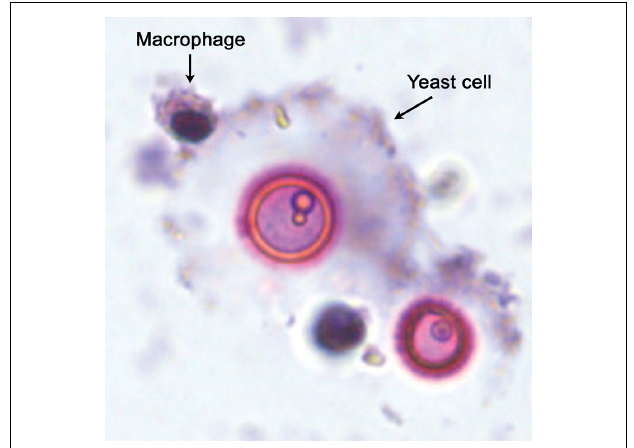
FIGURE 2 | Interaction between macrophages and cryptococcal giant/titan cells. Fungal giant/titan cells obtained from infected mice were co-incubated in vitro with RAW264.7 macrophage-like cells. As shown in the figure, the macrophages can recognize and bind to the fungal giant/titan cells, but they cannot internalize the fungal cells due to their enormous